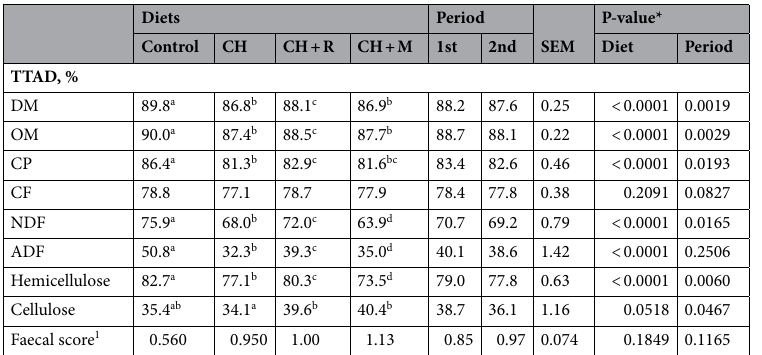
Table 2. Effect of diets on total tract apparent digestibility (TTAD) of nutrients and consistency of faeces. Control = control diet; CH = Chlorella vulgaris diet; CH + R = C. vulgaris diet supplemented with Rovabio® Excel AP; CH + M = C. vulgaris diet supplemented with a pre-selected enzymatic mixture. DM dry matter, OM organic matter, CP crude protein, CF crude fat, NDF neutral detergent fibre, ADF acid detergent fibre. 1 Faecal score: 0 (normal), 1 (soft faeces) or 2 (diarrhoea). *The interaction of the 2 factors (diet × period) was not significant for all the variables. a,b,c,d Values within a row with different superscripts differ significantly at P <